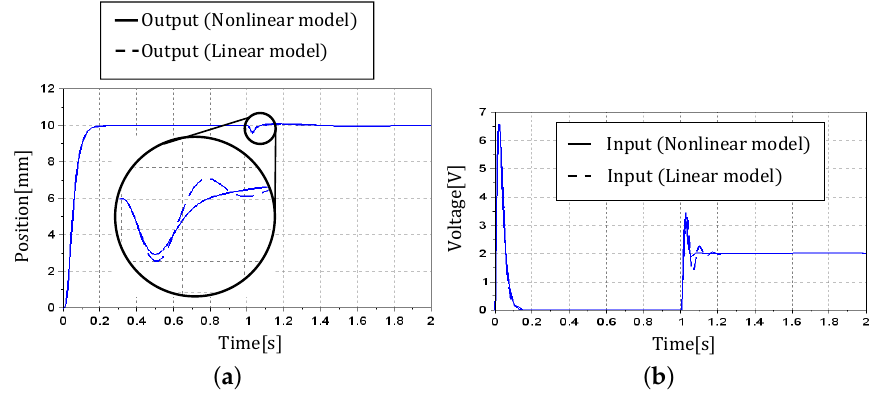
Figure 14. Simulation results of comparing with a linear model. ( a ) Position of stage. ( b ) Input voltage.